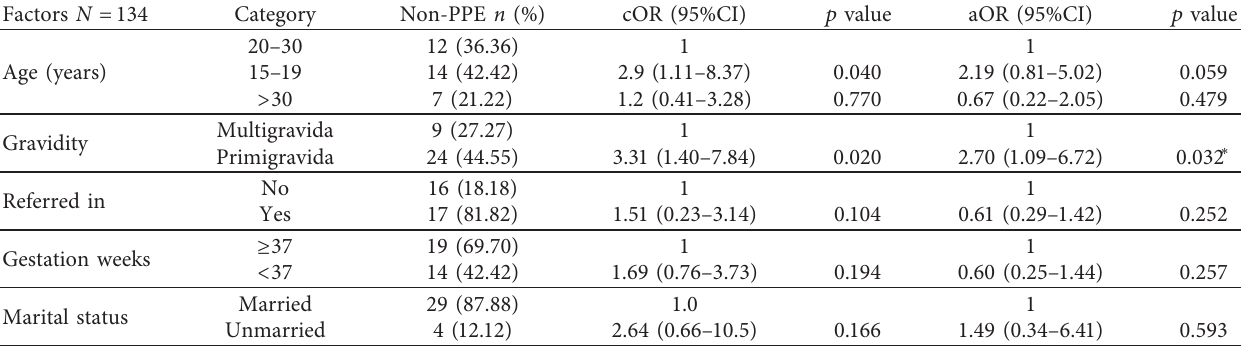
Table 2: Univariable and multivariable analyses for factors associated with nonproteinuric preeclampsia at Mbarara Regional Referral Hospital,